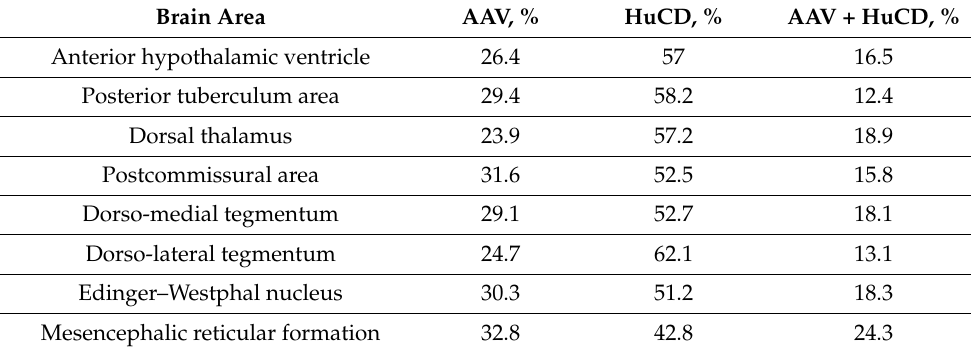
Table 2. Proportion of HuCD-immunopositive and rAAV-labeled neurons in the mesencephalic tegmentum of juvenile chum salmon, O. keta , at one week after a single injection of the vector. Brain Area AAV,